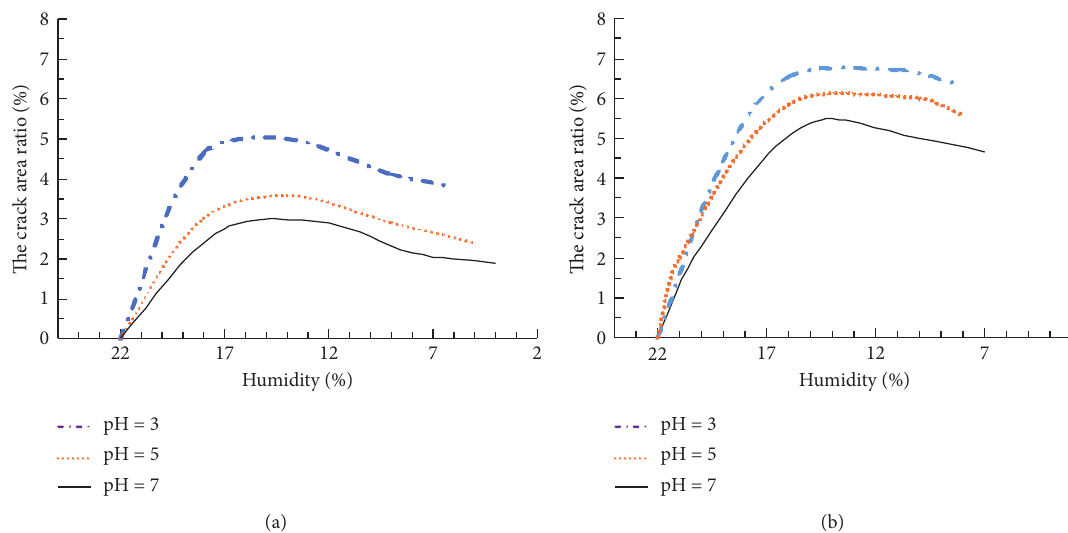
Figure 7: The crack area ratio under cyclic drying-wetting samples during the dehumidification process. (a) One-time cyclic drying-wetting. (b) Four-time cyclic drying-wetting.